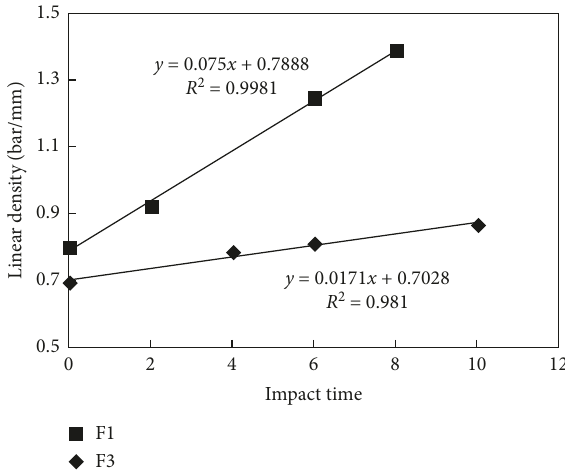
Figure 8: Plots of linear density to shock times for fat coal samples.